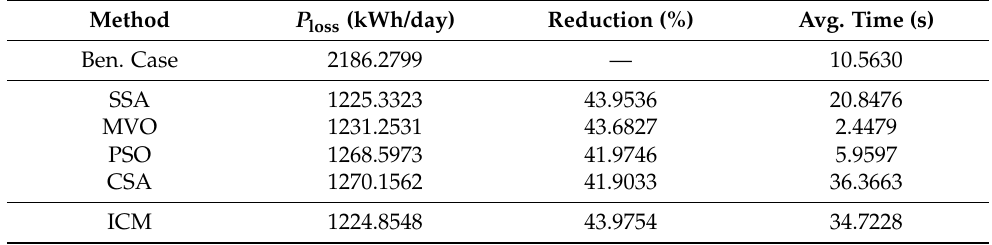
Table 2. Numerical comparison between the ICM approach and the combinatorial optimization